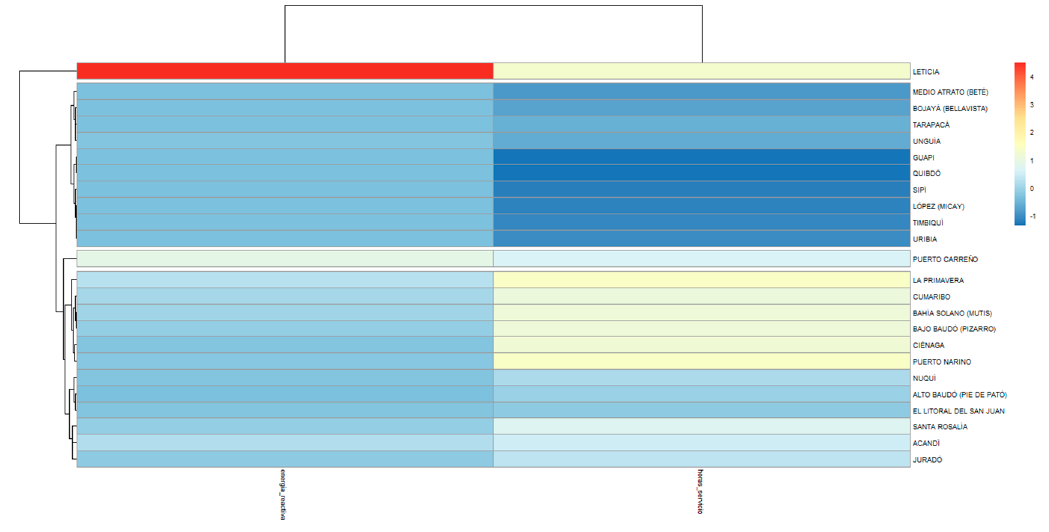
Figure 9. Dendrogram by DIANA algorithm (municipalities, hours of service, and reactive energy).